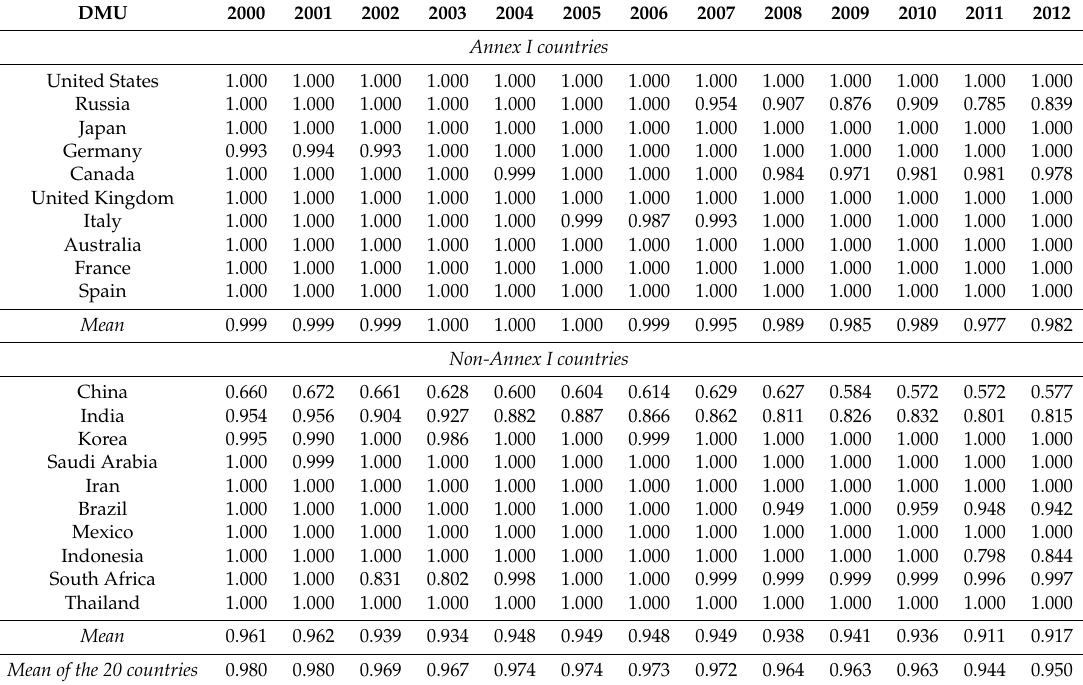
Table 5. The scores of Efficiency of the stage 3 in years